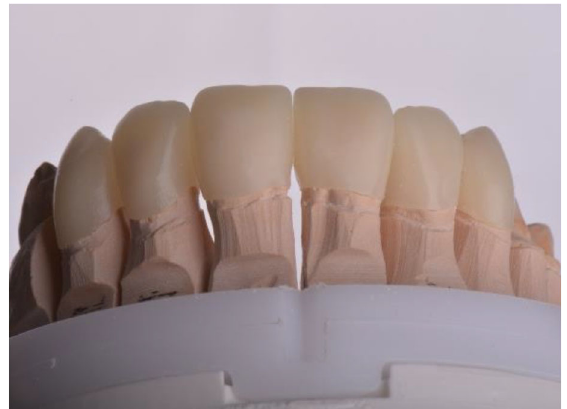
Figure 10. PMMA crowns on a model.